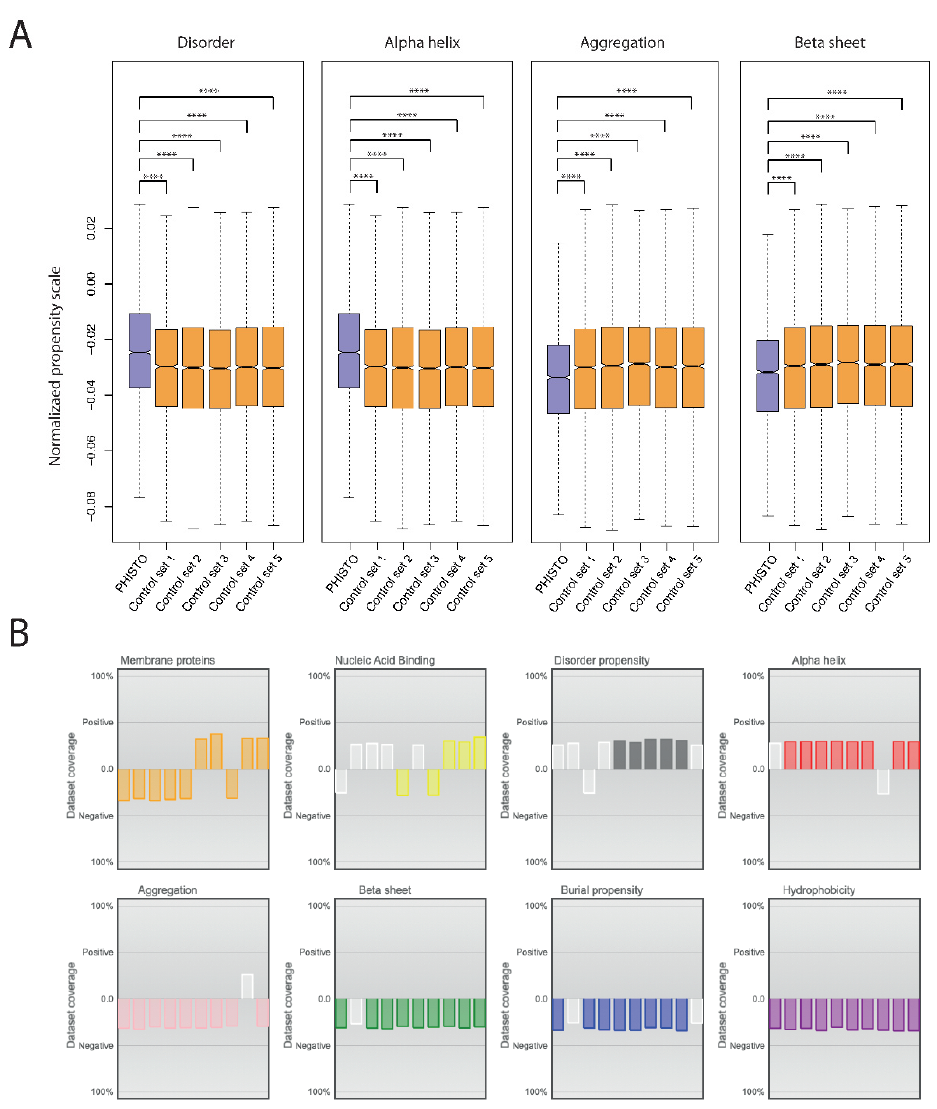
Figure 3. Physicochemical and structural properties of human proteins participating in host–pathogen interactions. ( A ) Boxplot representation of major properties for human proteins in PPIs compared to five groups of human proteins selected by random picking from the human proteome. ( B ) Overall representation of all scales used in CleverMachine for evaluating features in proteins. For a list of all properties evaluated, see [32]. Statistical comparisons were made using the Mann-Whitney U-test. **** p ≤ 0.0001